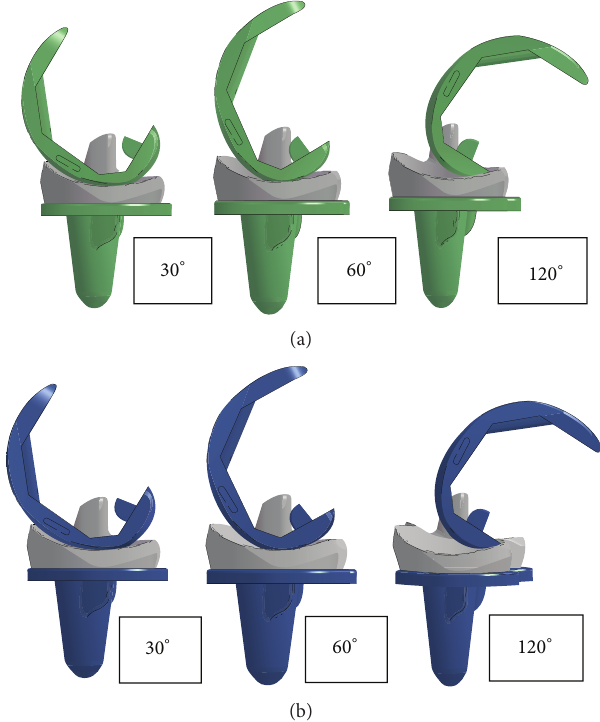
Figure 4: Lateral view of TKA during 30 ∘ , 60 ∘ , and 120 ∘ of flexion angle. (a) Mobile bearing. (b) Fixed